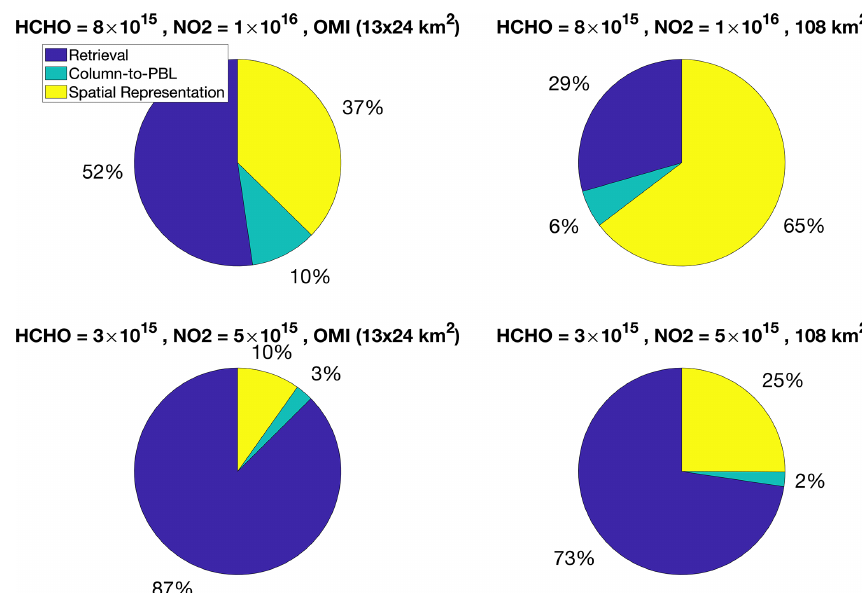
Figure 14. The fractional errors of retrieval (blue), column-to-PBL translation (green), and spatial representation (yellow) of the total error budget for different concentrations and footprints based on TROPOMI sigma values. The retrieval error used for the error budget is on a daily basis.